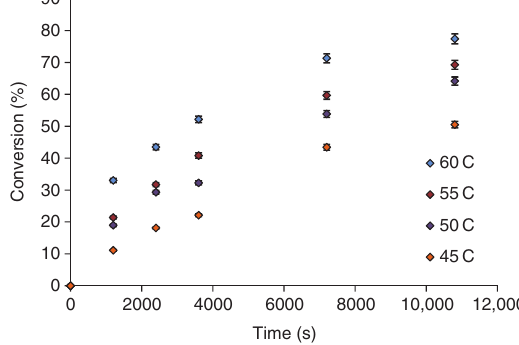
Figure 9 Effect of the reaction temperature on the percentage conversion.